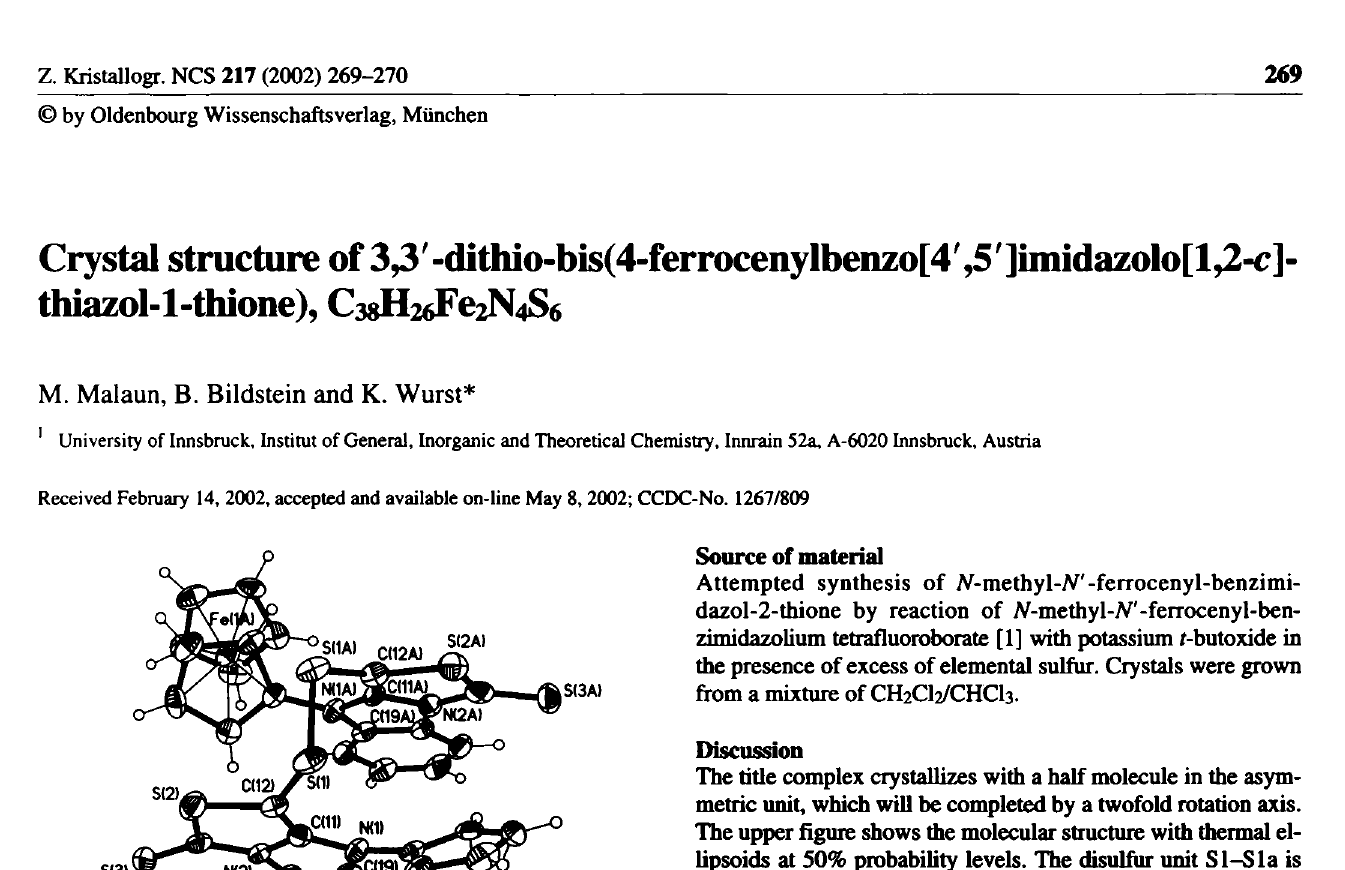
Table 1. Data collection and